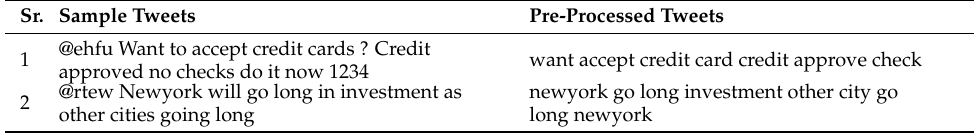
Table 3. Sample tweets after preprocessing.